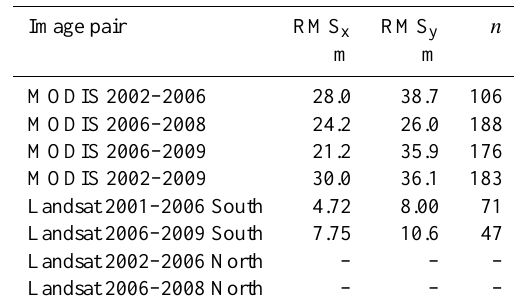
Table 2. Root mean square error (RMS) of displacement mea- surements obtained using frequency domain matching over stable ground. The number of measurements is indicated by n